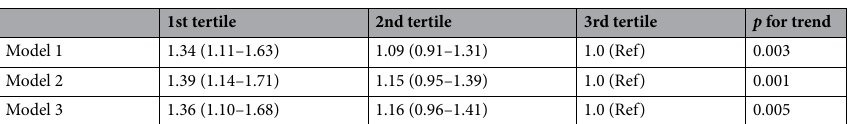
Table 2. Associations between periodontitis and serum TSH levels. Model 1: adjusted for age and sex. Model 2: adjusted for age, sex, BMI, smoking, alcohol consumption, exercise, fasting glucose, SBP, total cholesterol, eGFR, AST, and ALT. Model 3: adjusted for age, sex, BMI, smoking, alcohol consumption, exercise, fasting glucose, SBP, total cholesterol, eGFR, AST, ALT, log urine iodine, and TPOAb. CI confidence interval, OR odds ratio, BMI body mass index, SBP systolic blood pressure, eGFR estimated glomerular filtration ratio, AST aspartate transaminase, ALT alanine transaminase, TPO thyroid peroxidase, TSH thyroid-stimulating